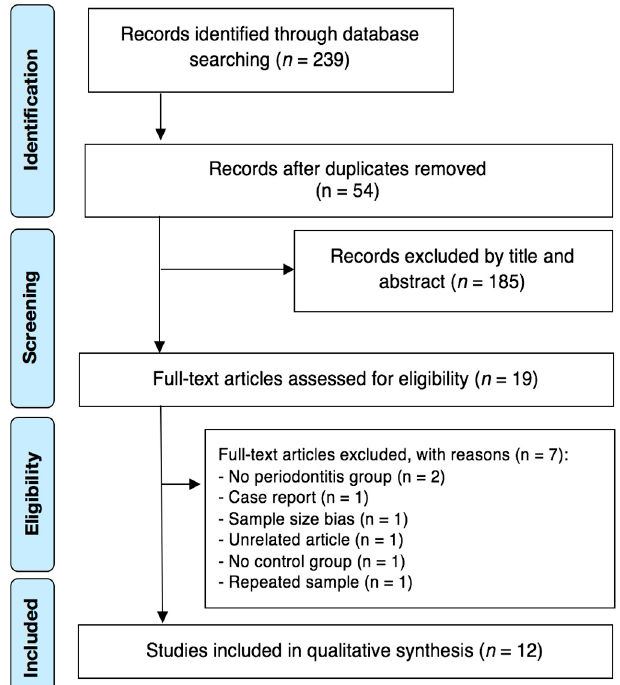
Figure 1. Article selection flow chart for the systematic review according to Preferred Reporting Items for Systematic Reviews and Meta-Analyses (PRISMA) guidelines.